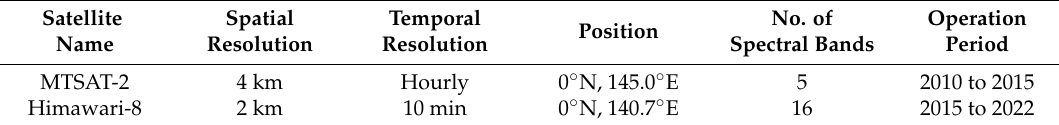
Table 1. Details of satellite data used in this